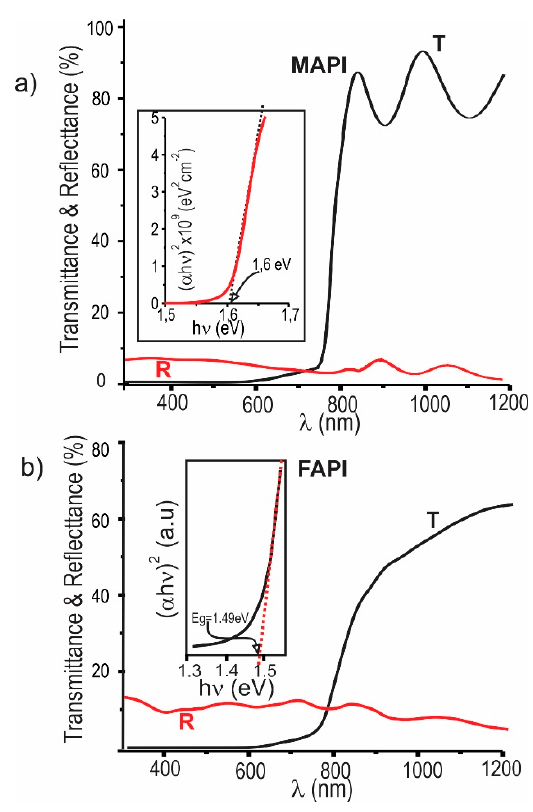
Figure 9. Transmittance and reflectance spectra of typical samples of ( a ) MAPI and ( b ) FAPI films free of secondary phases; in inset are displayed curves of α versus λ and of ( α h ν ) 2 versus h ν .